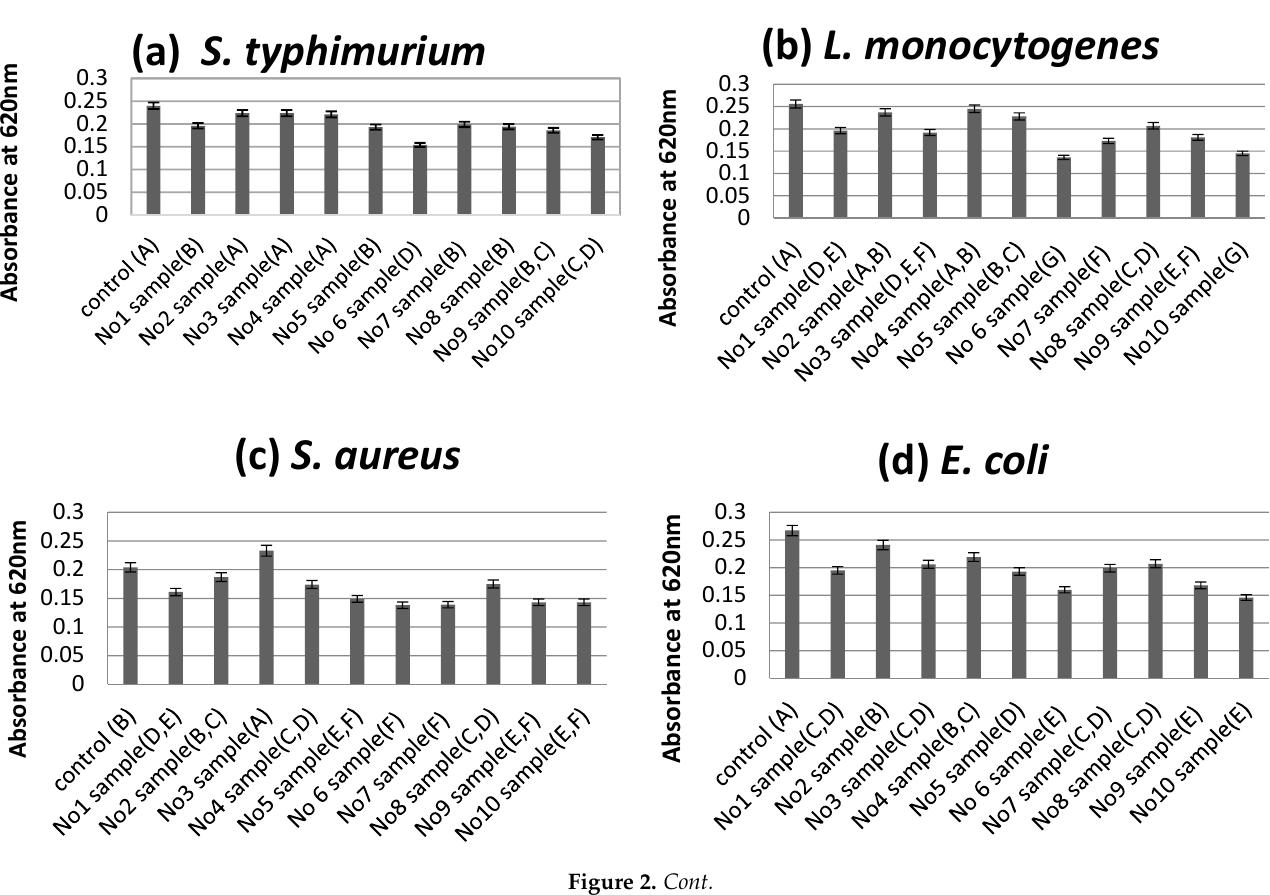
According to the turbidity assay results, sample No6 was shown to be the most effective at leading to a reduction of the absorbance at 620 nm as an effect of the addition of each sample at concentrations of 10 mg/mL, compared to the control (0 mg/mL) without antimicrobial extracts (Figure 2a–i).